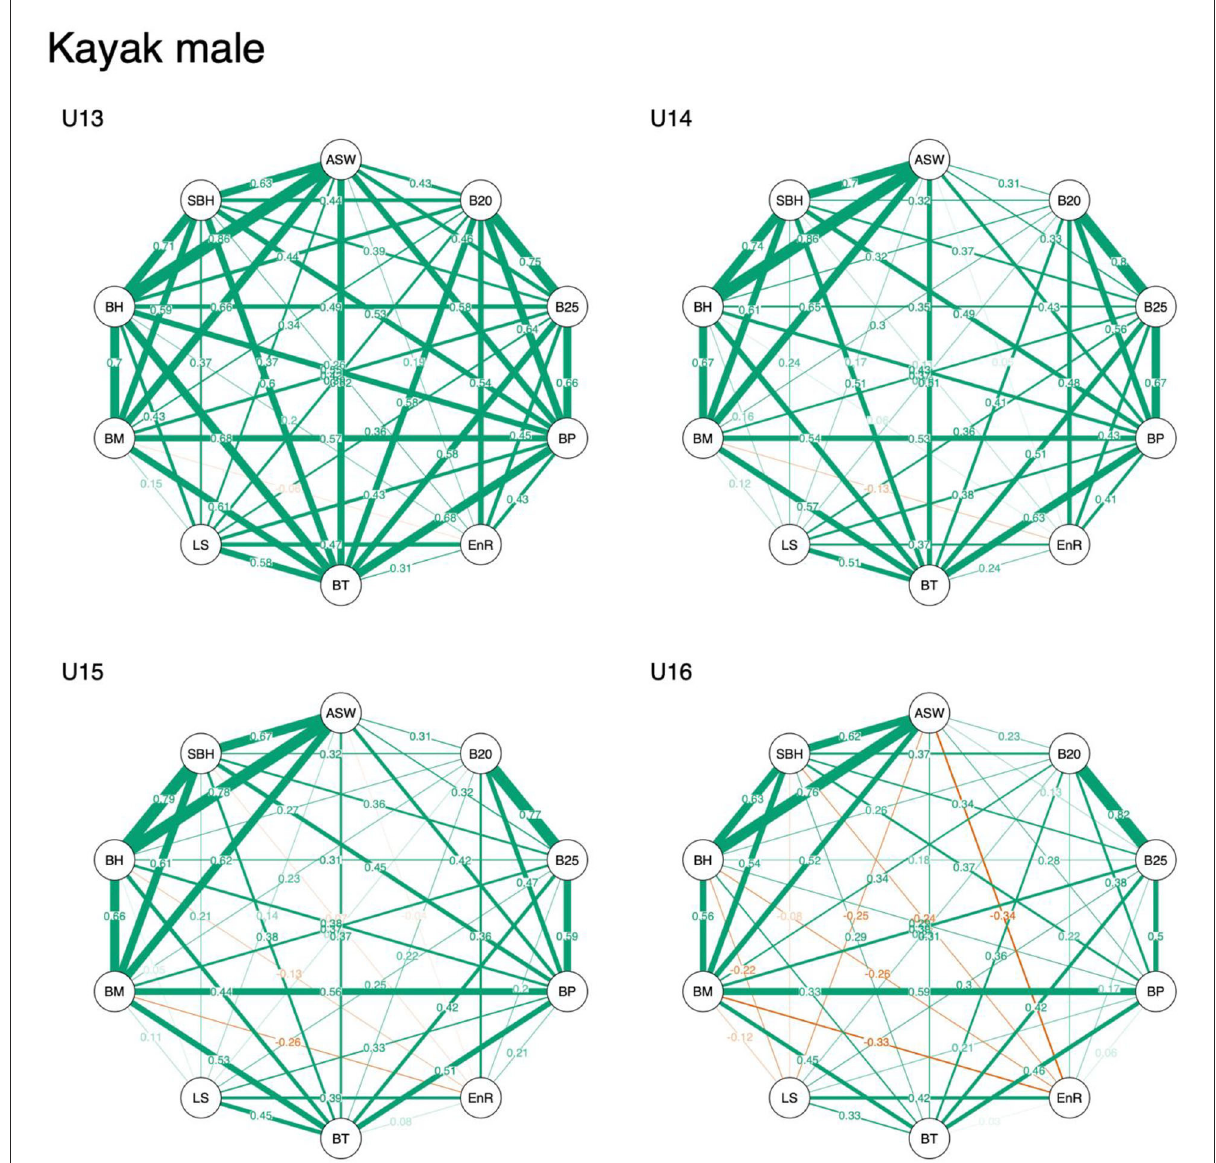
FIGURE2 Network representation of a correlation matrix of different test items of anthropometric, physical fitness, and sport-specific performance measures in young male kayakers. ASW, arm span width; B20, 2,000m on-water race; B25, 250m on-water race; BP, bench press and bench pull; EnR, 1,500m run; BT, underhand ball throw test; LS, 30m linear sprint; BM, body mass; BH, body height; SBH, sitting body